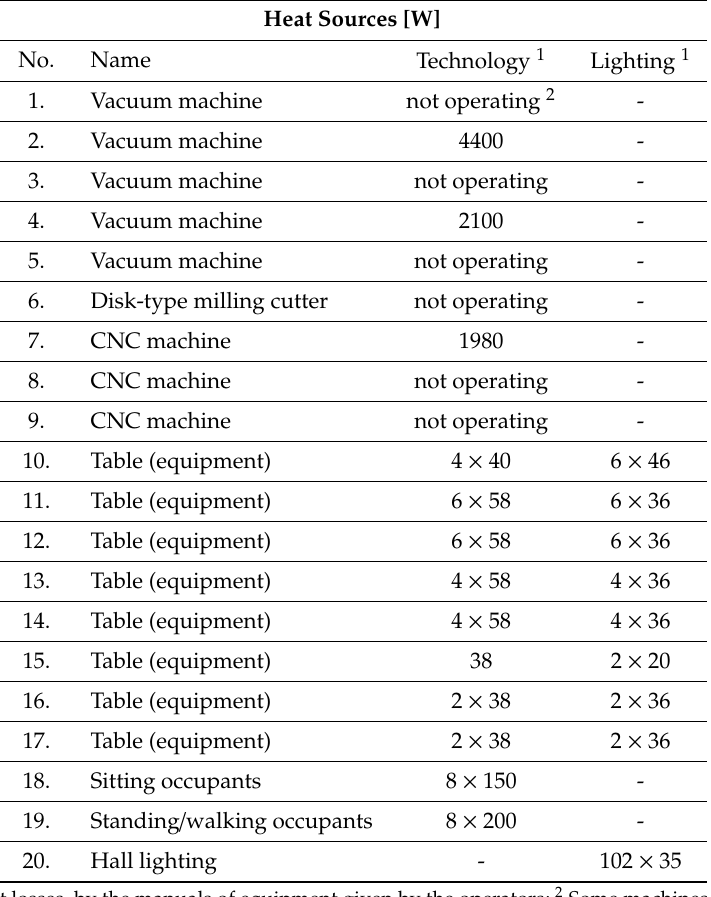
Table 3. Internal heat gains from occupants, equipment and artificial lighting (W) in the production